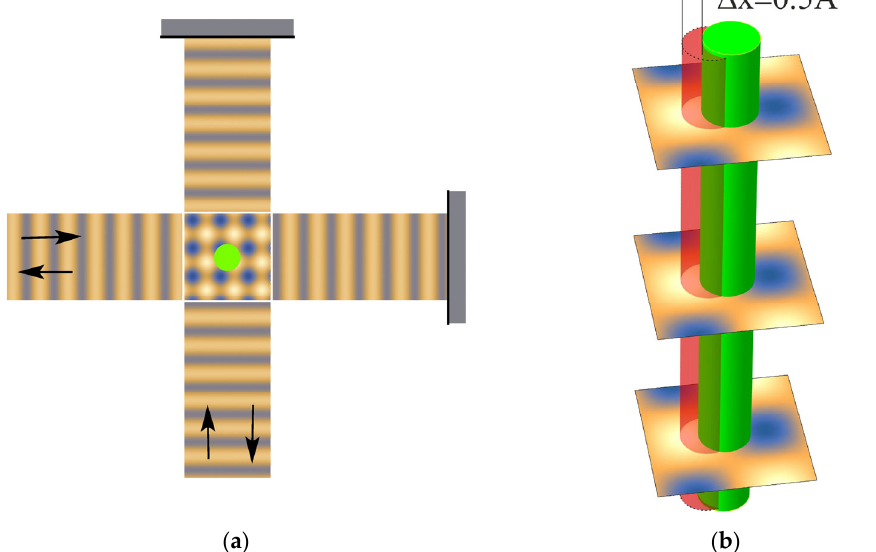
Figure 12. ( a ) Scheme of an experiment to demonstrate almost zero scattering at the frequency of the perfect invisibility mode. Excitation field distribution (17) is formed at the intersection of 2 standing waves. ( b ) Schematic of the operation of the displacement sensor at the frequency of the perfect invisibility mode. Excitation field distribution (17) is shown in horizontal cross ‐ sections (see also Figure 5). The green disk on ( a ) and the green cylinder on ( b ) characterize the position of the waveguide to provide extremely low scattering.